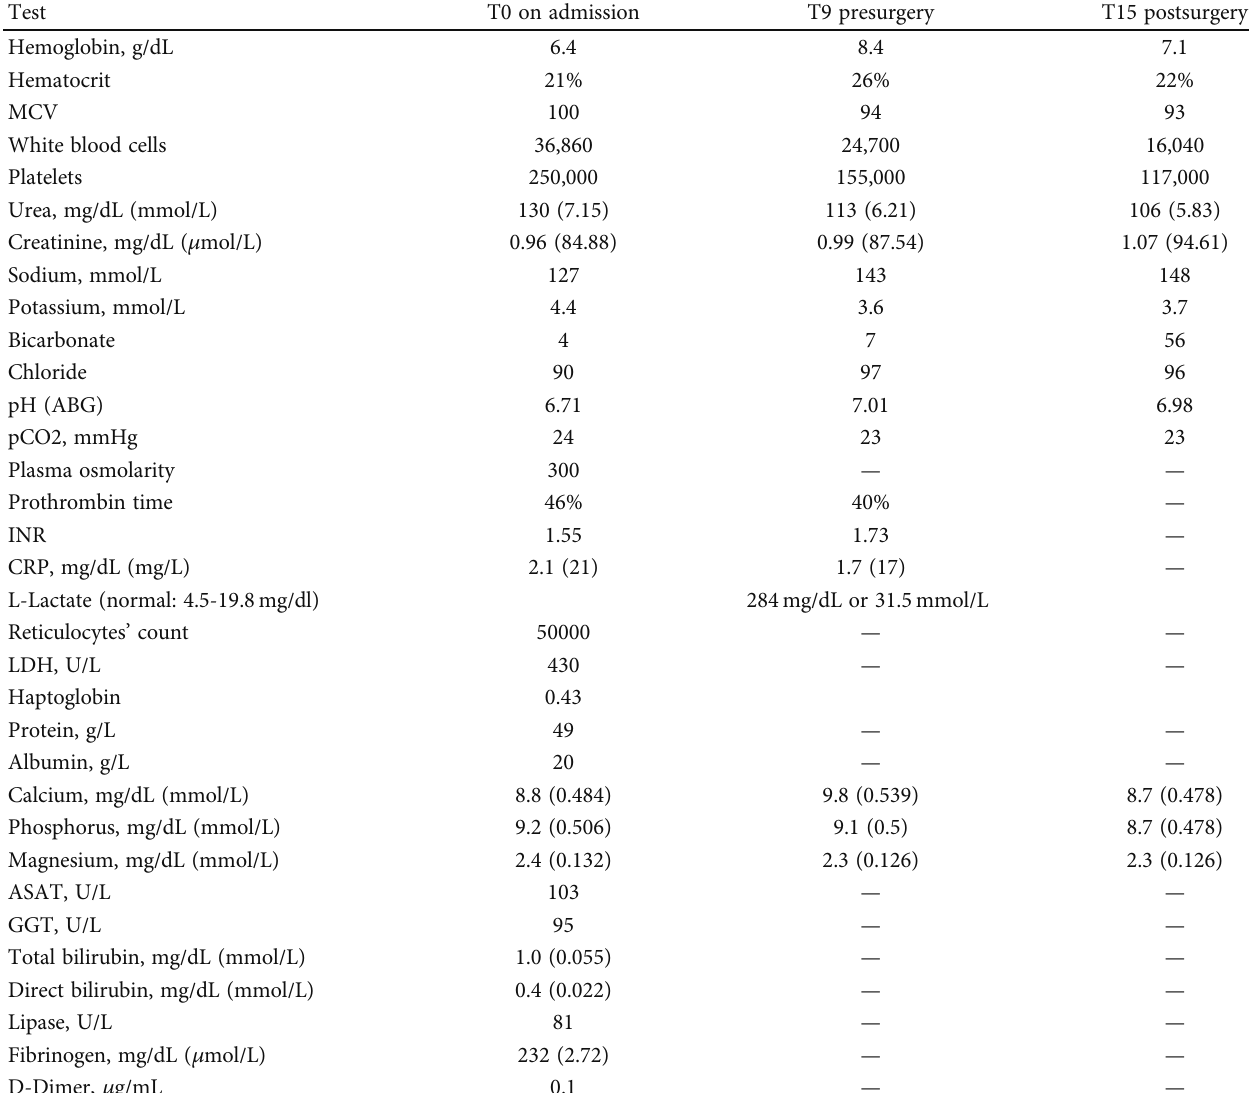
Table 1: Laboratory